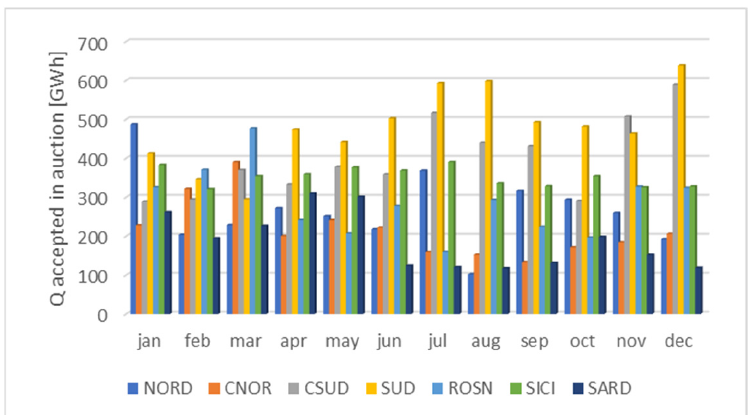
Figure 8. Distribution of the balancing capacity accepted in auction.